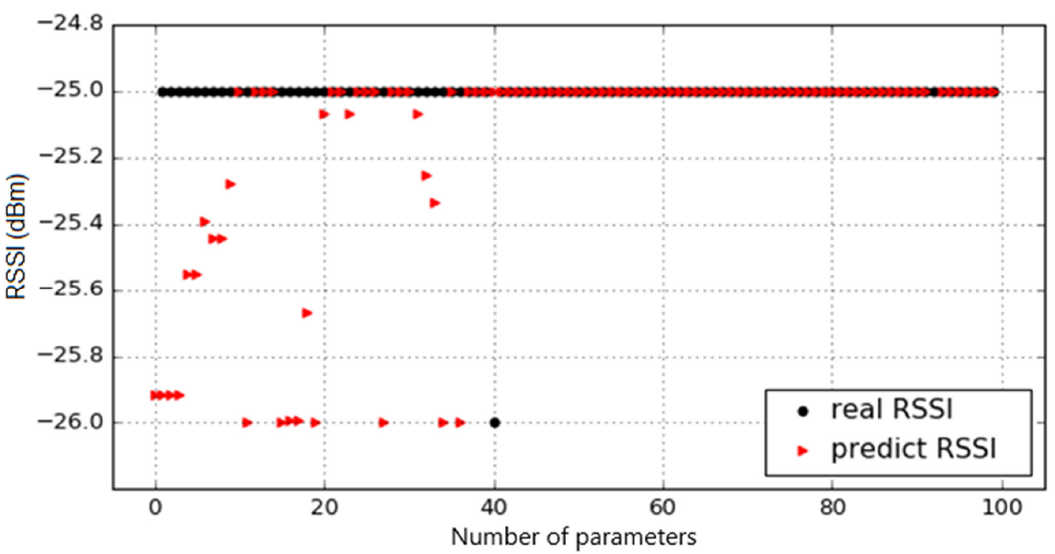
Figure 4. Example of the decision-tree regression method prediction.